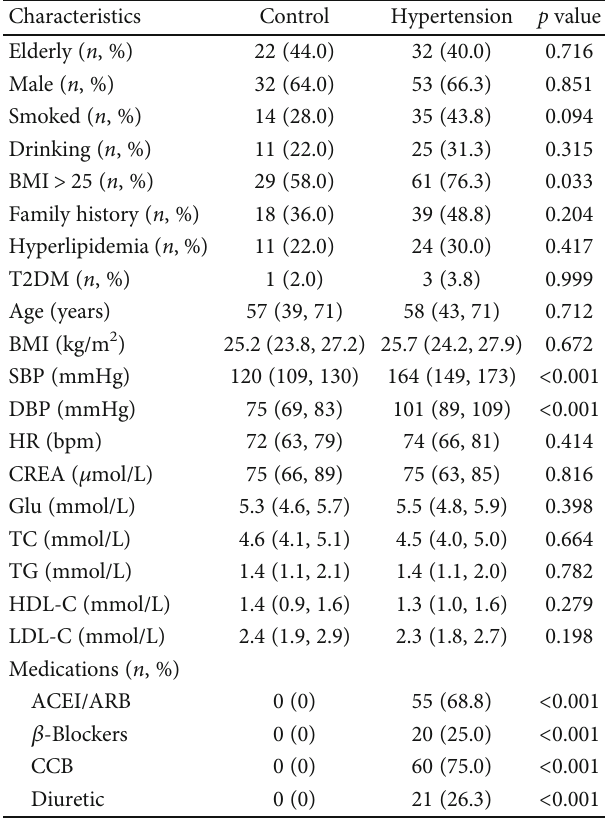
Table 2: Clinical characteristics of patients with or without